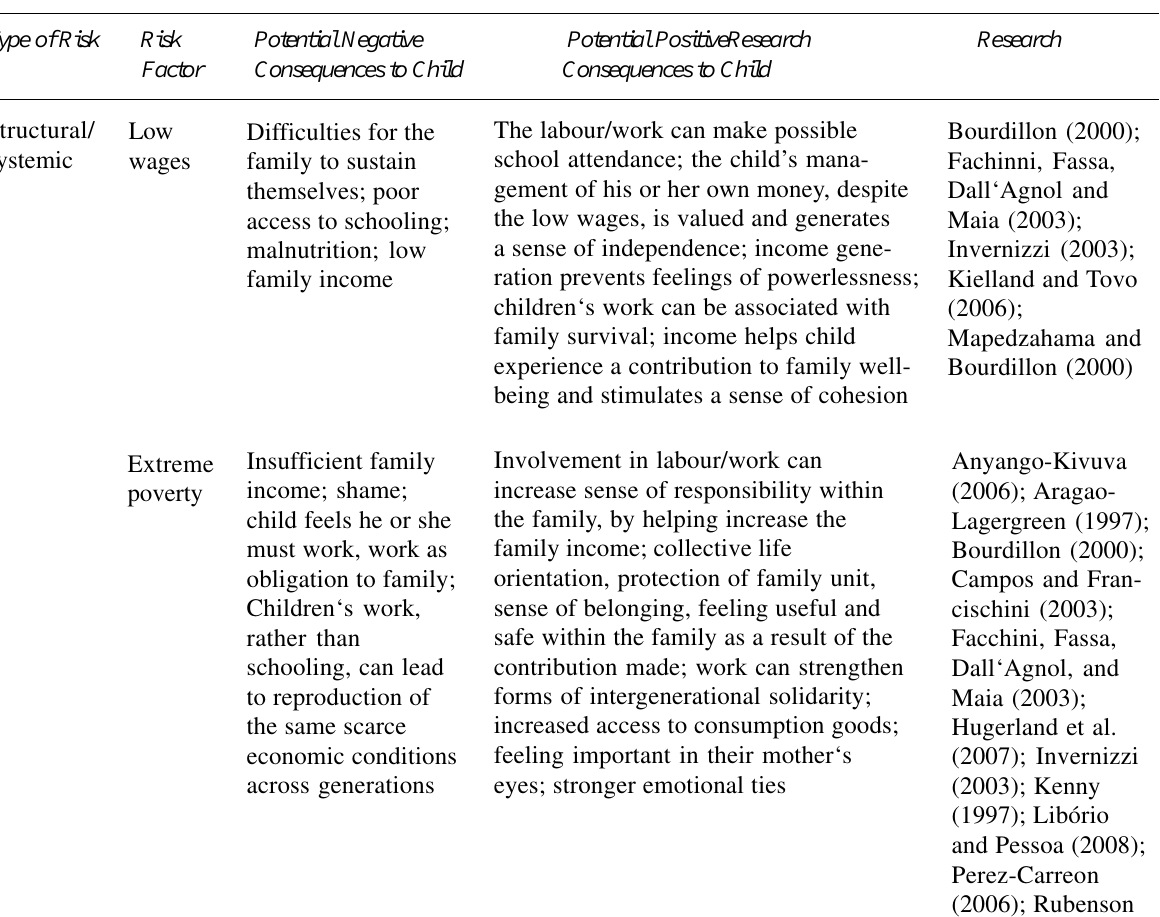
Structural/Systemic Risks and Potential Negative and Positive Consequences Associated with Children’s Labour/ Children’s